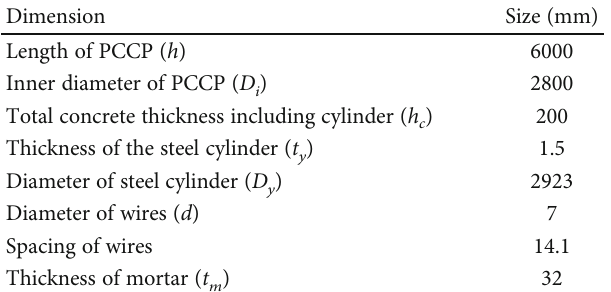
Figure 1: Structure of ECP. Table 1: Geometry of PCCP.